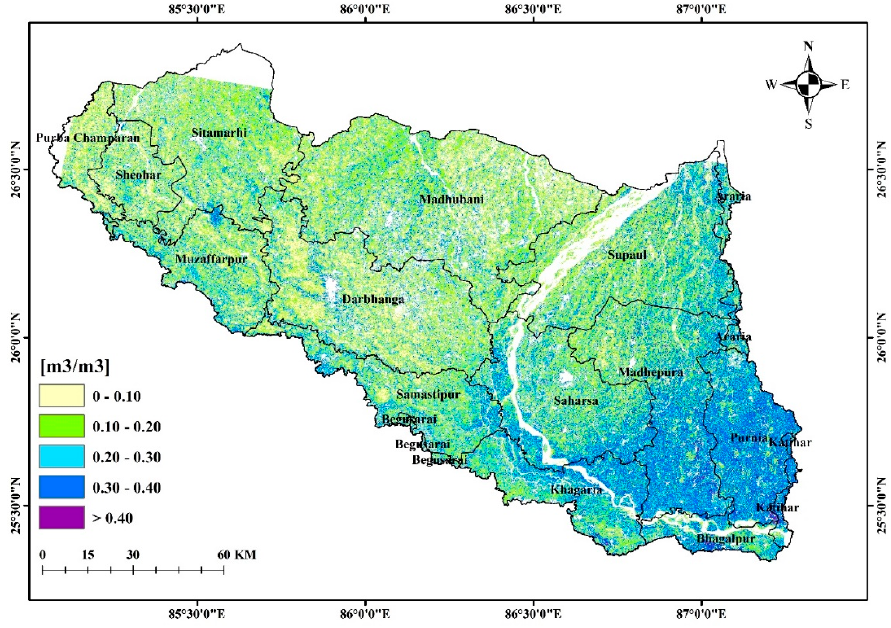
Figure 4. Spatial distribution of estimated SSM (m 3 /m 3 ) from C-band of Sentinel-1. Pixels shown in white correspond to the region where the NDVI mask was applied (> 0.4).